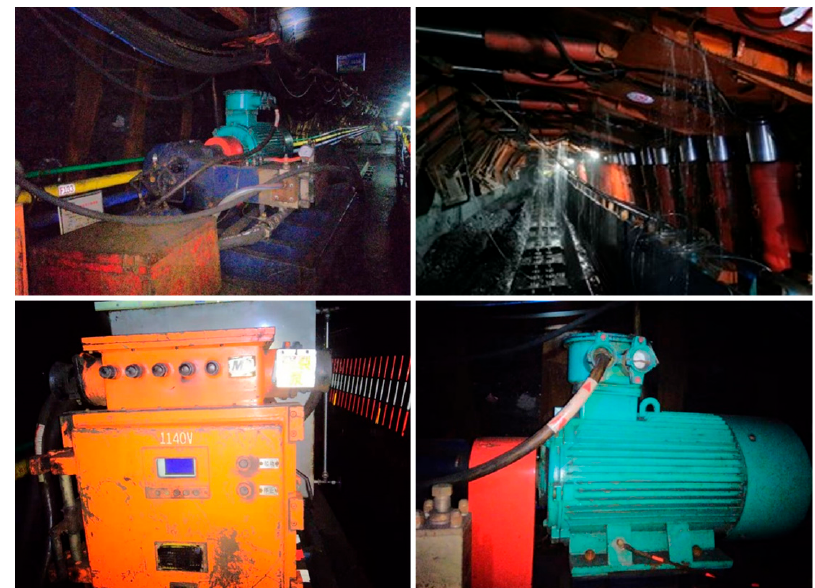
Figure 8. High ‐ pressure water injection system. Figure 8. High-pressure water injection system.